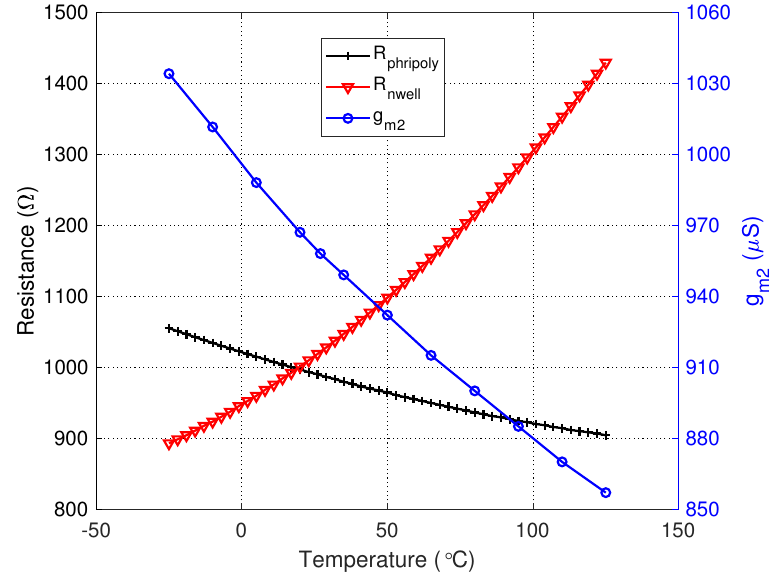
Figure 7. Resistances of R phripoly , R nwell , and transconductance of M 2 versus